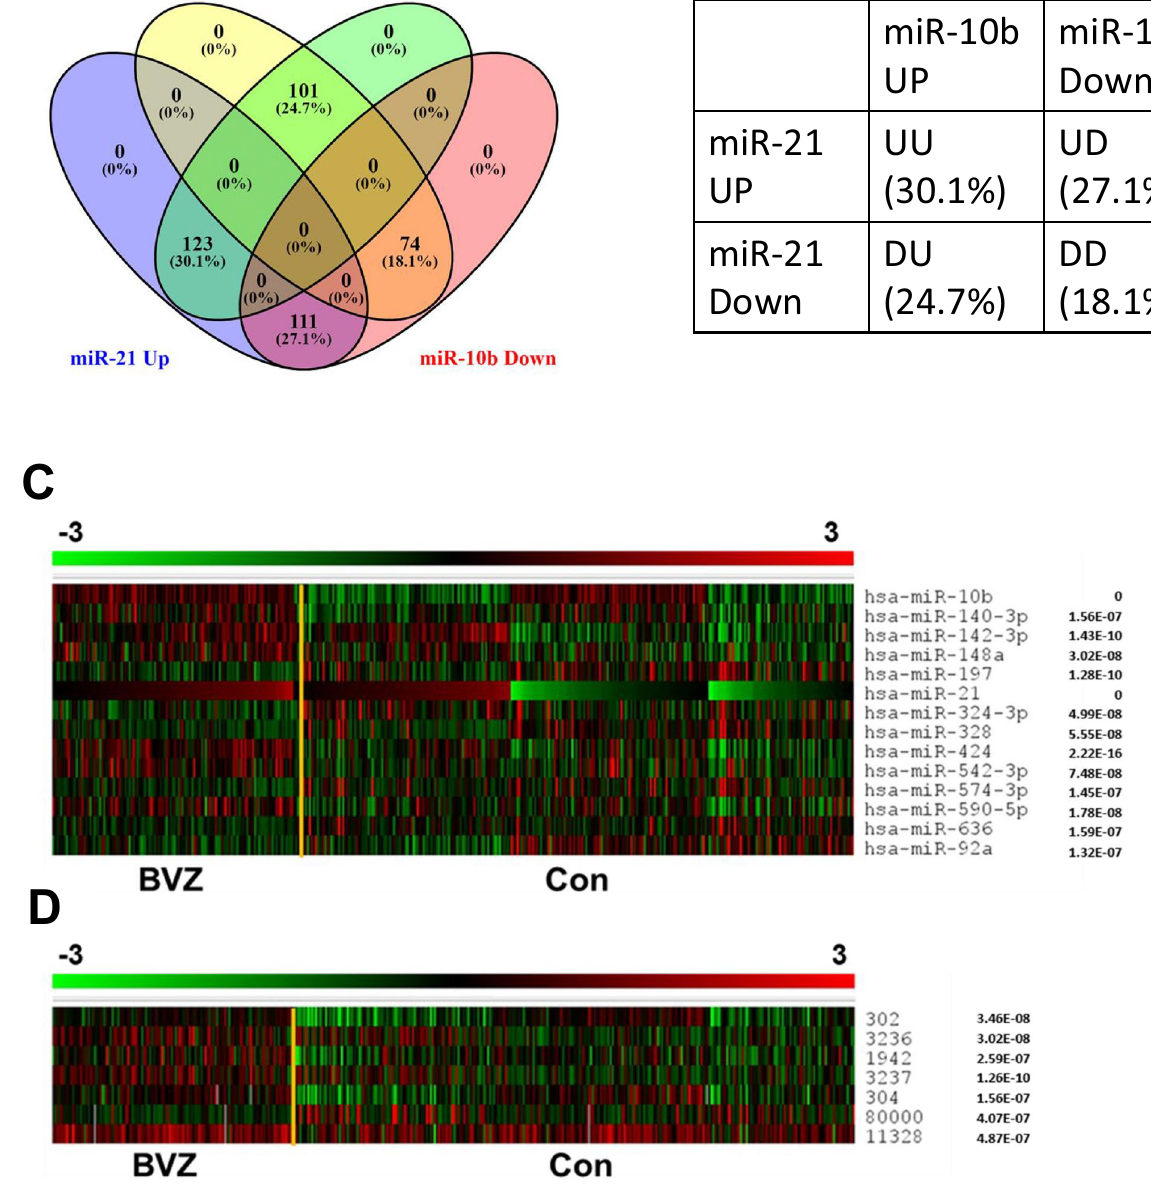
Figure 2. GBM BVZ subtypes and hierarchical clustering heatmaps of miRNAs and mRNAs. ( A ) The upregulated expression z-scores of miR-21 and miR-10b (UU) define the GBM BVZ subtype, which is present in ~ 30% of all GBM patients. ( B ) The table shows all four subgroups of GBM, their labels, and percentages. ( C ) Hierarchical clustering heatmap of miRNAs in GBM BVZ and CON subtypes. The DE 14 miRNAs and their p -values are listed on the right of the map, p = < 0.0001 vs the control, n = 409. ( D ) Hierarchical clustering heatmap of mRNAs in these two GBM subgroups. Those seven mRNA IDs and their p -values are listed on the right of the map, p = < 0.01 vs the control, n = 409. Rulers of miRNA and mRNA expression are above the pictures, where − 3 to 3 correspond to green to red. The yellow lines separate the GBM BVZ and its control subgroups, and the left sides of the lines are the GBM BVZ subtypes. If a p -value is less than 1.0E-10, the software will give zero as the p